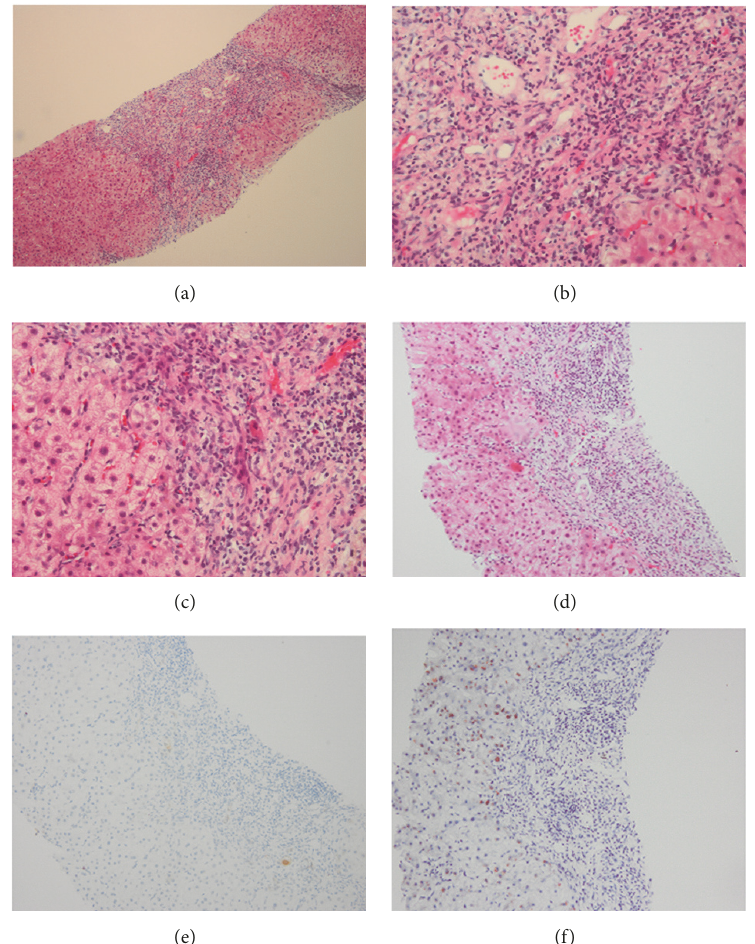
Figure 2: Histological features of decompensated PBC-AIH patients. (a) Bridging necrosis and moderate to severe interface hepatitis ( × 100, HE staining); (b) prominent interface hepatitis with numerous plasma cells ( × 400, HE staining); (c) typical rosetting of hepatocytes in the area of interface hepatitis ( × 400, HE staining); (d), (e), (f) interlobular bile duct loss without a significant ductular reaction ( × 200, HE staining, CK7 staining, and copper staining in sequence).